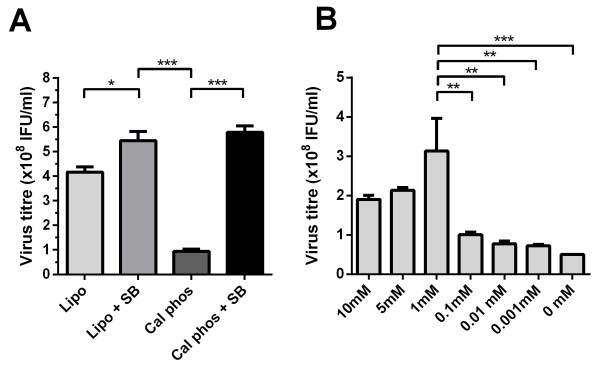
High titre virus generated in 293T cells using calcium phosphate and sodium butyrate. A. 293T cells were transfected with pCCL, psPAX2 and pMD2. G packaging plasmids using lipofectamine in the presence or absence of sodium butyrate, or calcium phosphate in the presence or absence of sodium butyrate. Data shown represents mean ± s.d. of six independent transfections B. Calcium phosphate transfection in 293T cells was performed using decreasing concentrations of sodium butyrate. Data represent mean ± s.d. of three independent experiments. *P < 0.05, **P < 0.01, ***P < 0.001 using one-way ANOVA with Bonferroni comparison.